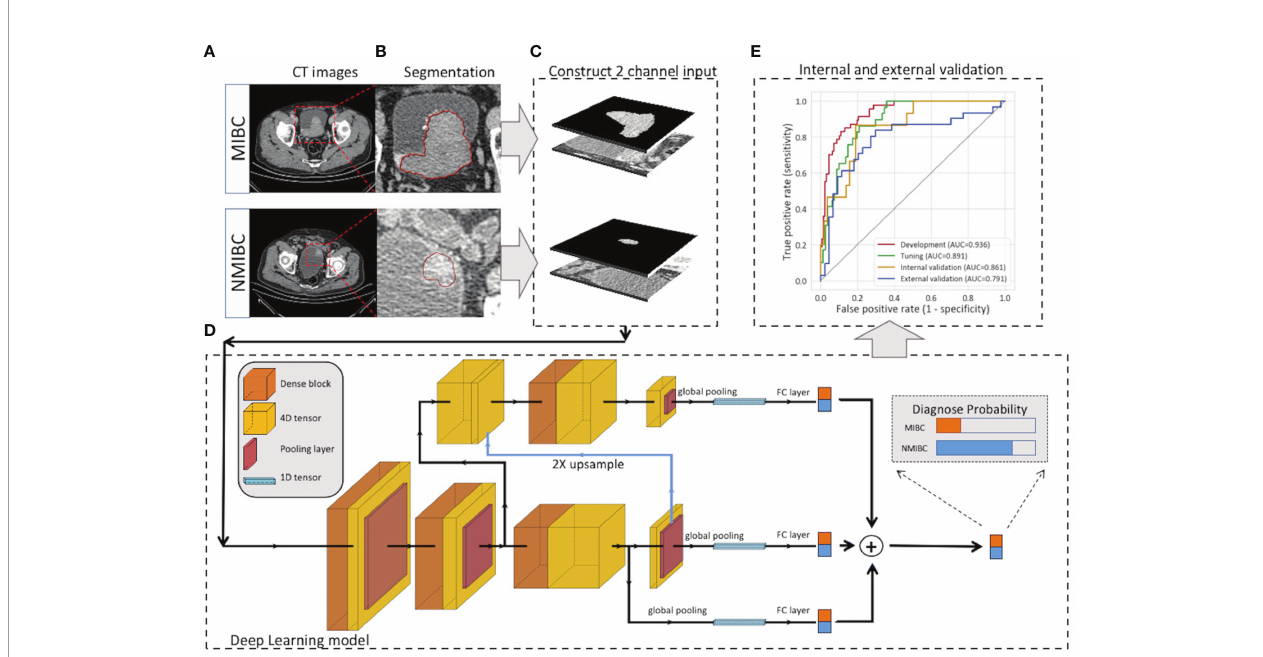
FIGURE 2 | Work fl ow of the deep learning model for the prediction of muscle invasiveness status in bladder cancer patients. (A) Collection of the CT images of MIBC and NMIBC. (B) Semiautomatic segmentation of the tumor region. (C) The masked tumor region and the original tumor region were stacked vertically to form the input volume, and the cropped 2-channel input was constructed. (D) The structure of our deep-learning model. The model was constructed on the basis of Filter-guided Pyramid Network (FGP-Net), a novel 3D convolutional network structure that is designed to capture the global feature and the local features simultaneously. (E) Internal and external validation of our model. CT, computed tomography; FC, fully connected layer.